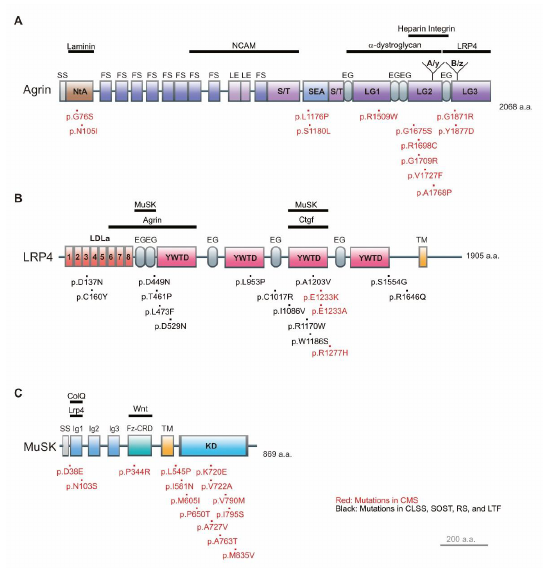
Figure 2. Structures and disease-causing missense mutations of agrin, Lrp4, and MuSK. The domains of agrin, Lrp4, and MuSK are indicated by squares and ovals, and are drawn to scale. Bars on the top indicate the positions where binding to a partner occurs. Mutations in congenital myasthenic syndrome (CMS) are indicated in red, and mutations in Cenani–Lenz syndactyly syndrome (CLSS), sclerosteosis type 2-like symptoms (SOST2), Richter syndrome (RS), and low-trauma fracture (LTF) are indicated in black. ( A ) Human agrin domains. SS, secretion signal peptide; NtA, N-terminal Agrin; FS, follistatin-like domain; LE, laminin EGF–like domain; S/T, serine/threonine-rich domain; SEA, a sperm protein, enteroki- nase, and agrin domain; EG, EGF-like domain; and LG1-3, laminin G-like domain 1–3. A/y and B/z are alternative exons included in the neuronal isoforms of agrin. ( B ) Human Lrp4 domains. LDLa, low-density lipoprotein receptor domain class A; EG, EGF-like domain; YWTD, β-propeller domain; TM, transmembrane domain. ( C ) Human MuSK domains. SS, secretion signal peptide; Ig1-3, immunoglobulin domain 1–3; Fz-CRD, Frizzled-like cysteine-rich domain; TM, transmem- brane domain; and KD, kinase domain.